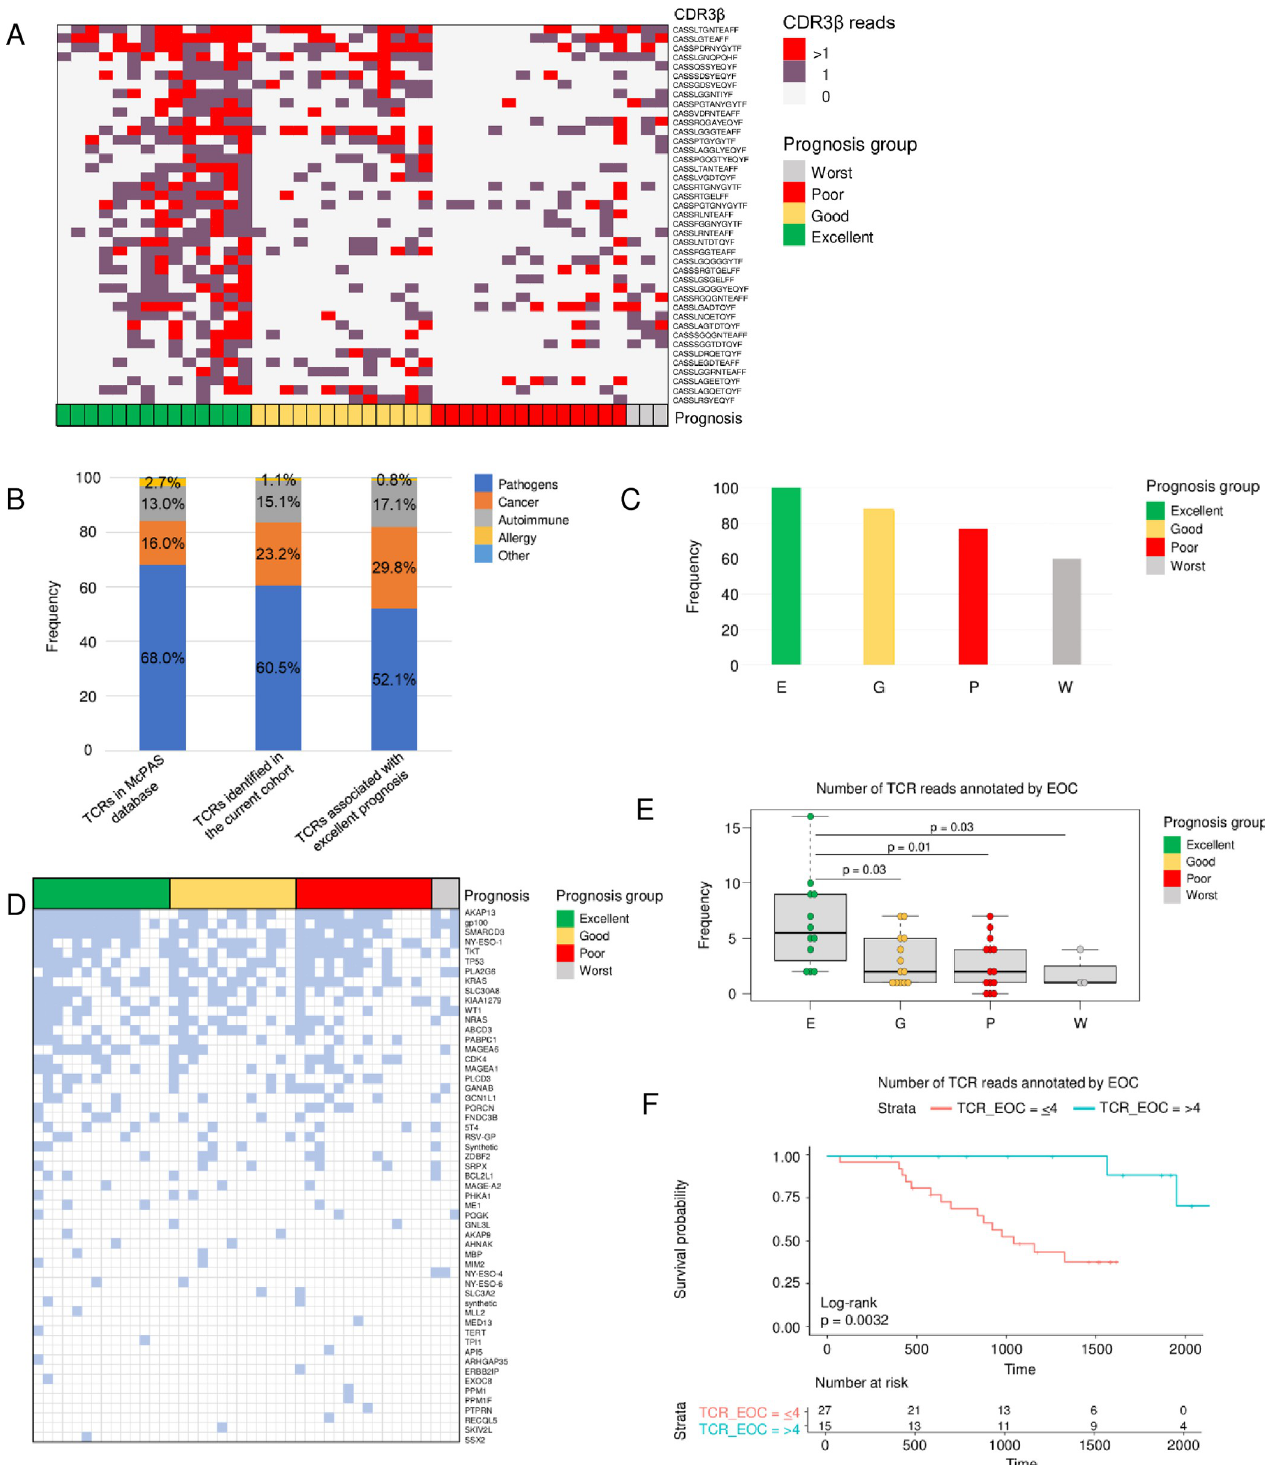
Fig 3. Association of CDR3 β peptides with prognosis and annotation in McPAS and VDJ databases. (A) Heatmap of the CDR3 β peptides associated with prognosis in the current study, showing that the identified CDR3 β peptides are more common and abundant in patients with an excellent prognosis. (B) Annotation by McPAS functional category of CDR3 β peptides found in all T cell receptors (TCRs) annotated in the McPAS database (left), TCRs found in the current cohort (middle), and TCRs associated with prognosis in the current cohort (right). The annotation revealed that CDR3 β peptides associated with